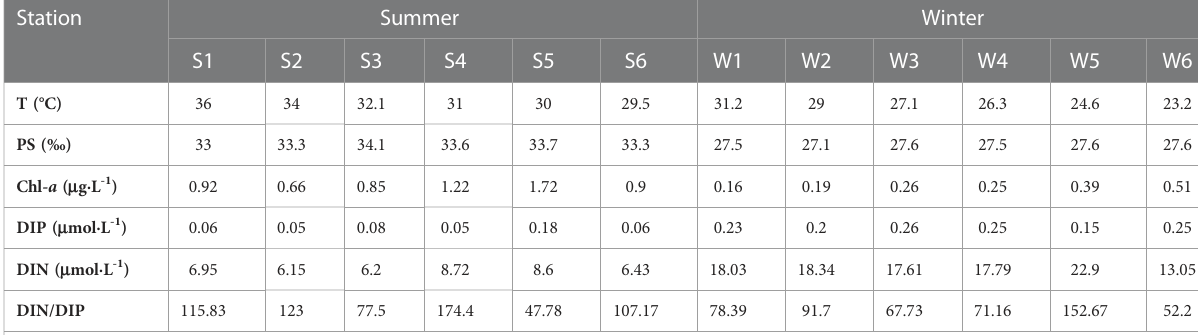
TABLE 1 Environmental parameters of study area during summer and winter in Daya Bay. Station